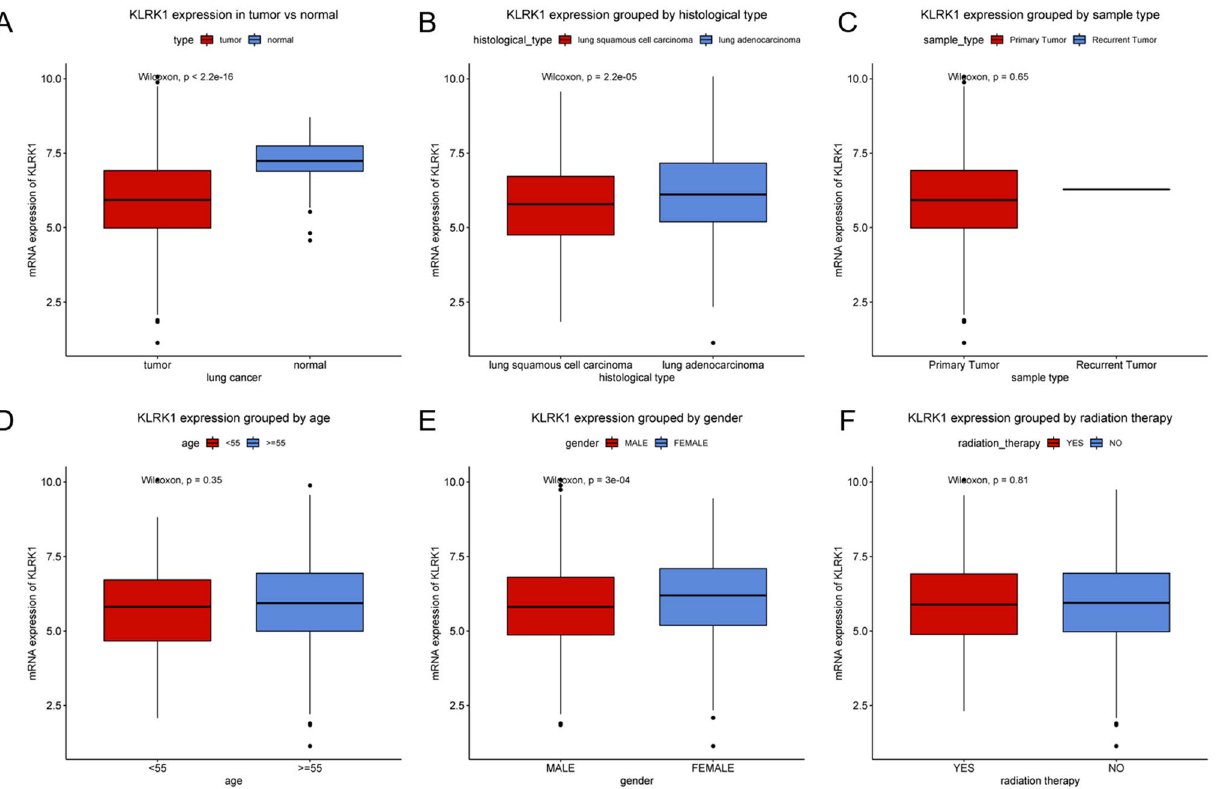
Figure 1. KLRK1 expression in lung cancer. Expression of KLRK1 grouped by ( A ) tumor vs. normal tissue, ( B ) histological type, ( C ) sample type, ( D ) age, ( E ) gender, and ( F ) radiation